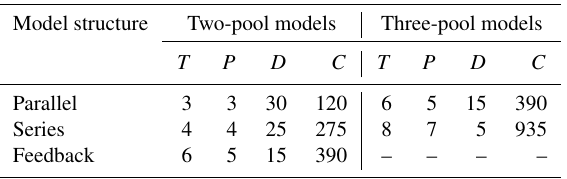
Table 3. Minimum number of time points in datasets fitted to each model structure T , number of parameters for each model structure P , number of datasets used for each model structure D , and the pos- sible number of combinations of parameters to identify with specific combinations of available data C